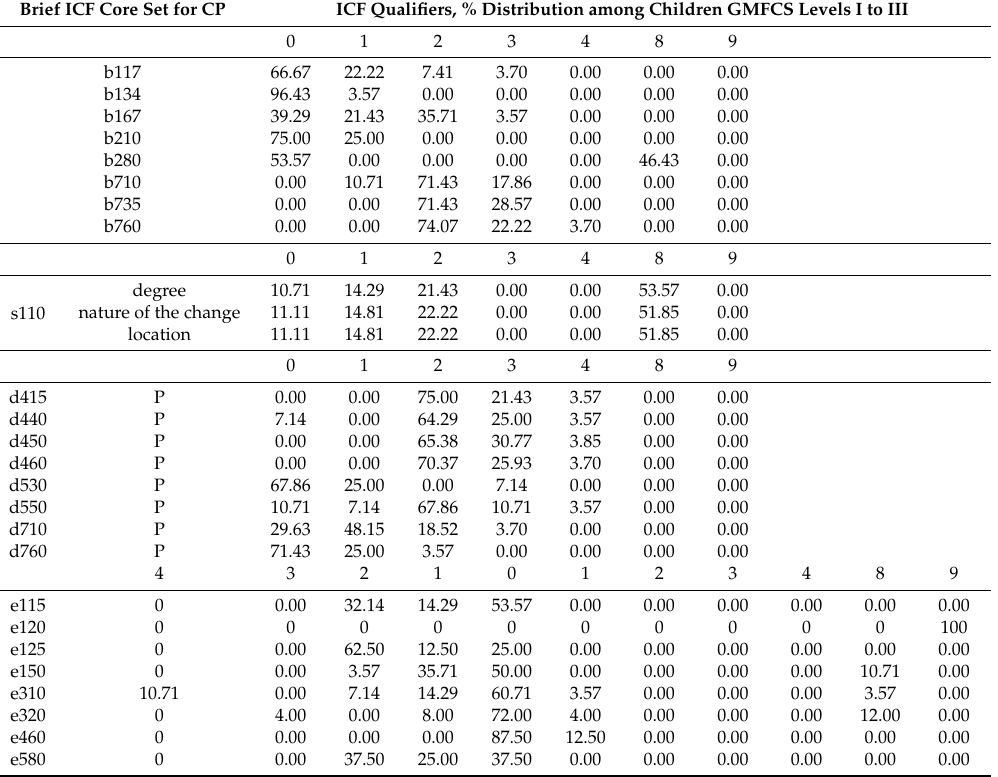
Table 2. Functioning profile of the Russian children with CP, Gross Motor Function Classification System (GMFCS) levels I to III ( n =